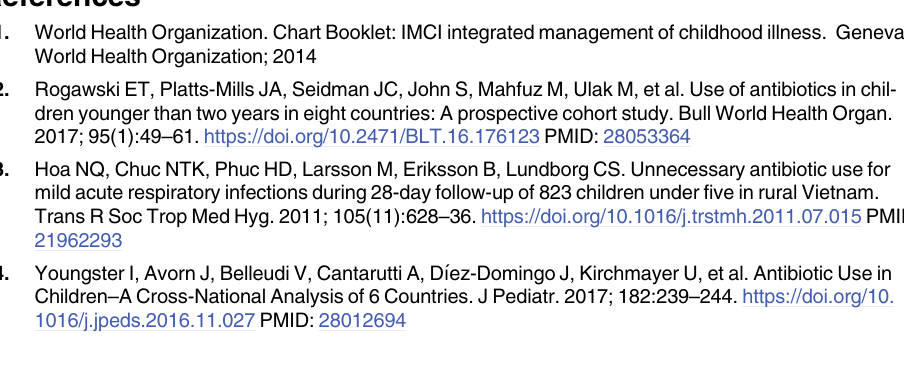
S1 Table. Classes of antibiotics used and reason for